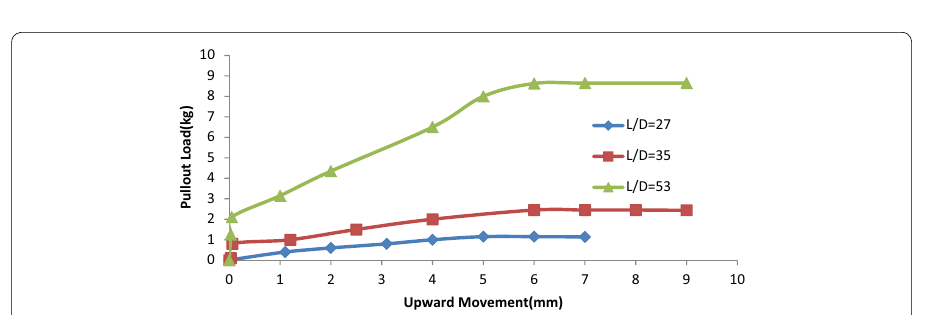
Fig. 16 Pullout load-upward movement curves for helical pile with single helix (dh